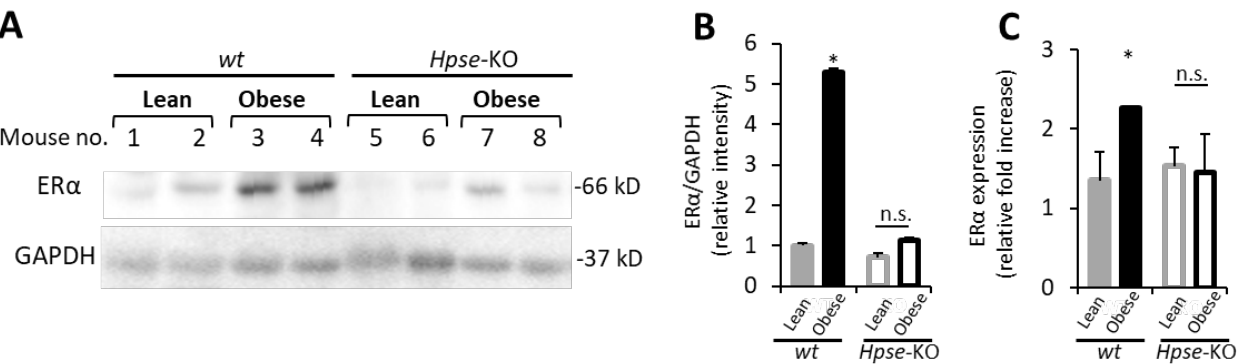
Figure 5. Heparanase deficiency abolishes effect of obesity on ER α expression in the murine model of BC. Wild-type ( wt ) and heparanase-null ( Hpse − KO) female C57BL6 mice were made obese by administration of HFD for 12 consecutive weeks, as described in Methods. Control (lean) mice were feed with a regular diet. HFD-fed animals of both wt and Hpse − KO genotypes became obese, as evidenced by their significantly increased body weight compared to control diet-fed lean mice ( wt : 38% increase p < 0.001; Hpse − KO: 49% increase, p < 0.03). Then, all mice were injected with E0771 cells into the 4th mammary fat pad, as described in Methods. Tumors were harvested 14 days post cell injection and lysates of tumor tissue were analyzed for expression of ER α protein ( A , B ) and mRNA ( C ). ( A , B ) Levels of full length 66 kDa ER α protein in the orthotopic E0771 tumors derived from lean and obese mice, were analyzed by immunoblotting ( A ). The band intensity was quantified using ImageJ software; intensity ratio for ER α /GAPDH is shown, n ≤ 5 mice per condition ( B ). Error bars represent ± SD; * p < 0.0002; n.s: no statistical difference. ( C ) qRT-PCR was used to determine the levels of ER α mRNA in tumor tissue samples collected from lean and obese mice.